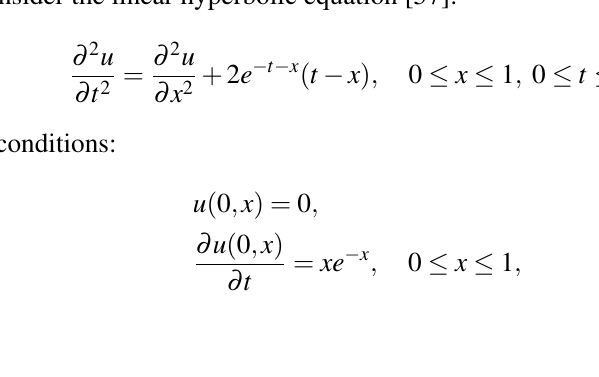
Table 5. Numerical results of Test Problem 7 at t = 1 and